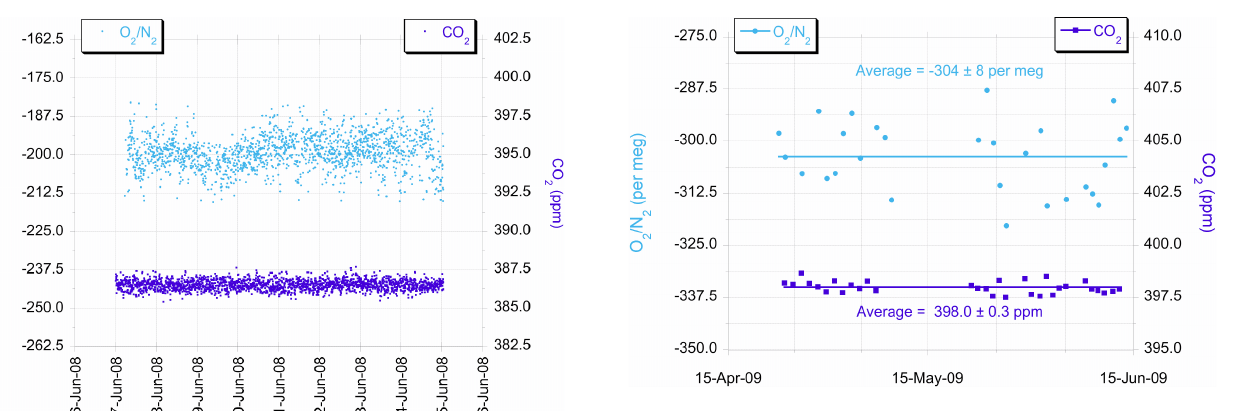
Fig. 5. Measurements of the target cylinder for δ O 2 /N 2 (lighter cir- cles) and for CO 2 (darker squares), measured during April through June 2009. Both y -axes have been adjusted so that their ranges are nearly the same on a molar